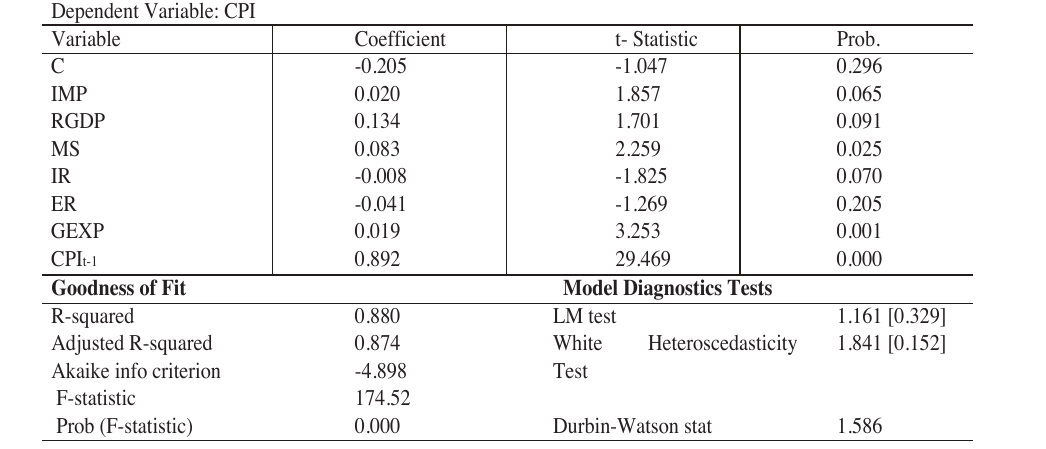
Results of the OLS (Ordinary Least